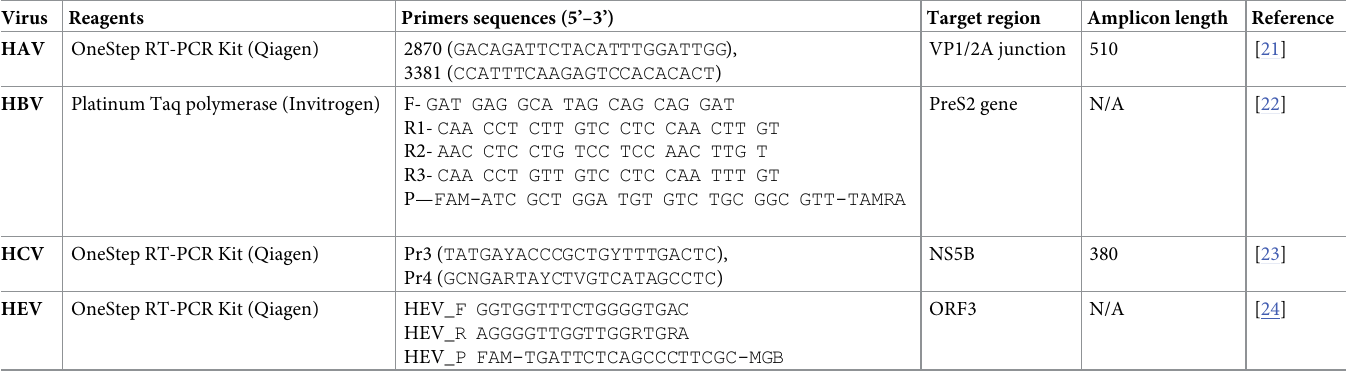
Table 1. List of primers and target regions of